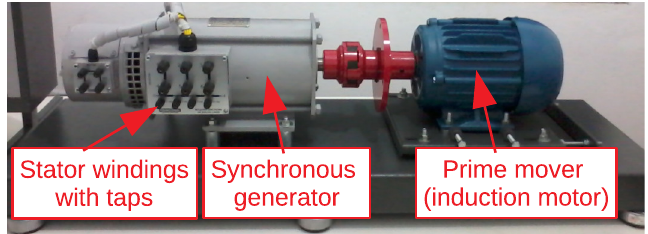
Figure 9. Test bench with 2 kW/220 V/60 Hz synchronous generator.